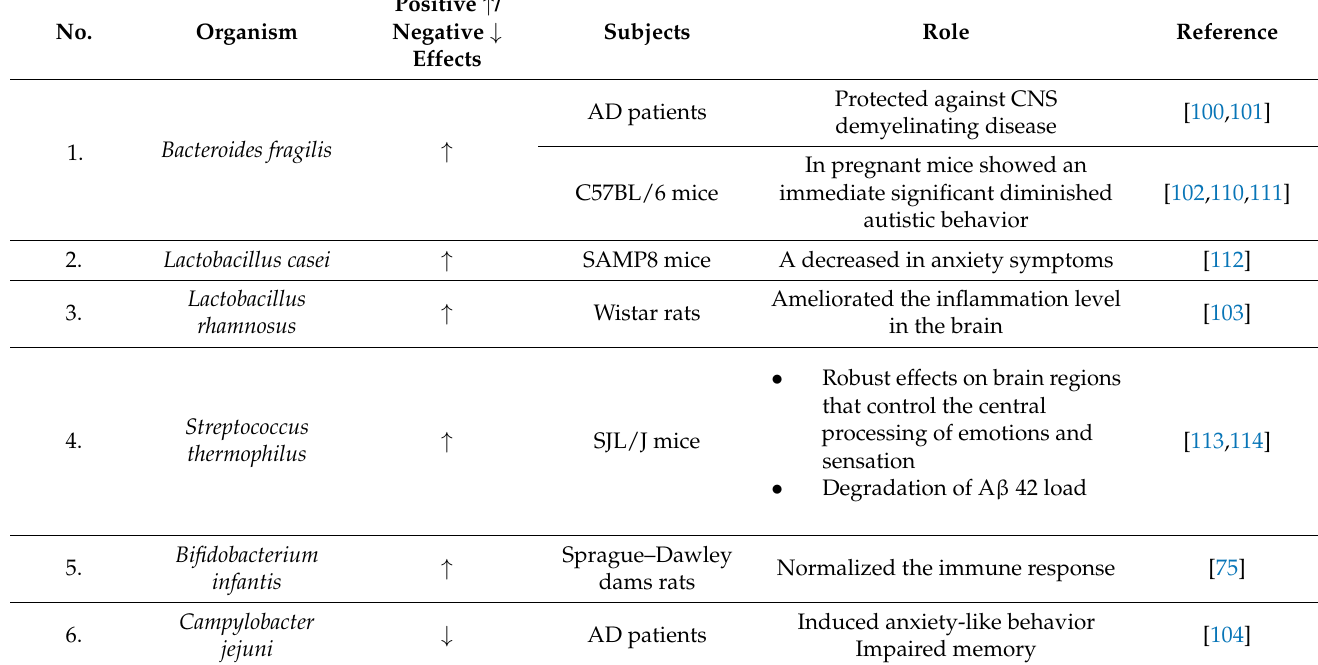
Table 2. Roles played by different microorganisms residing in the